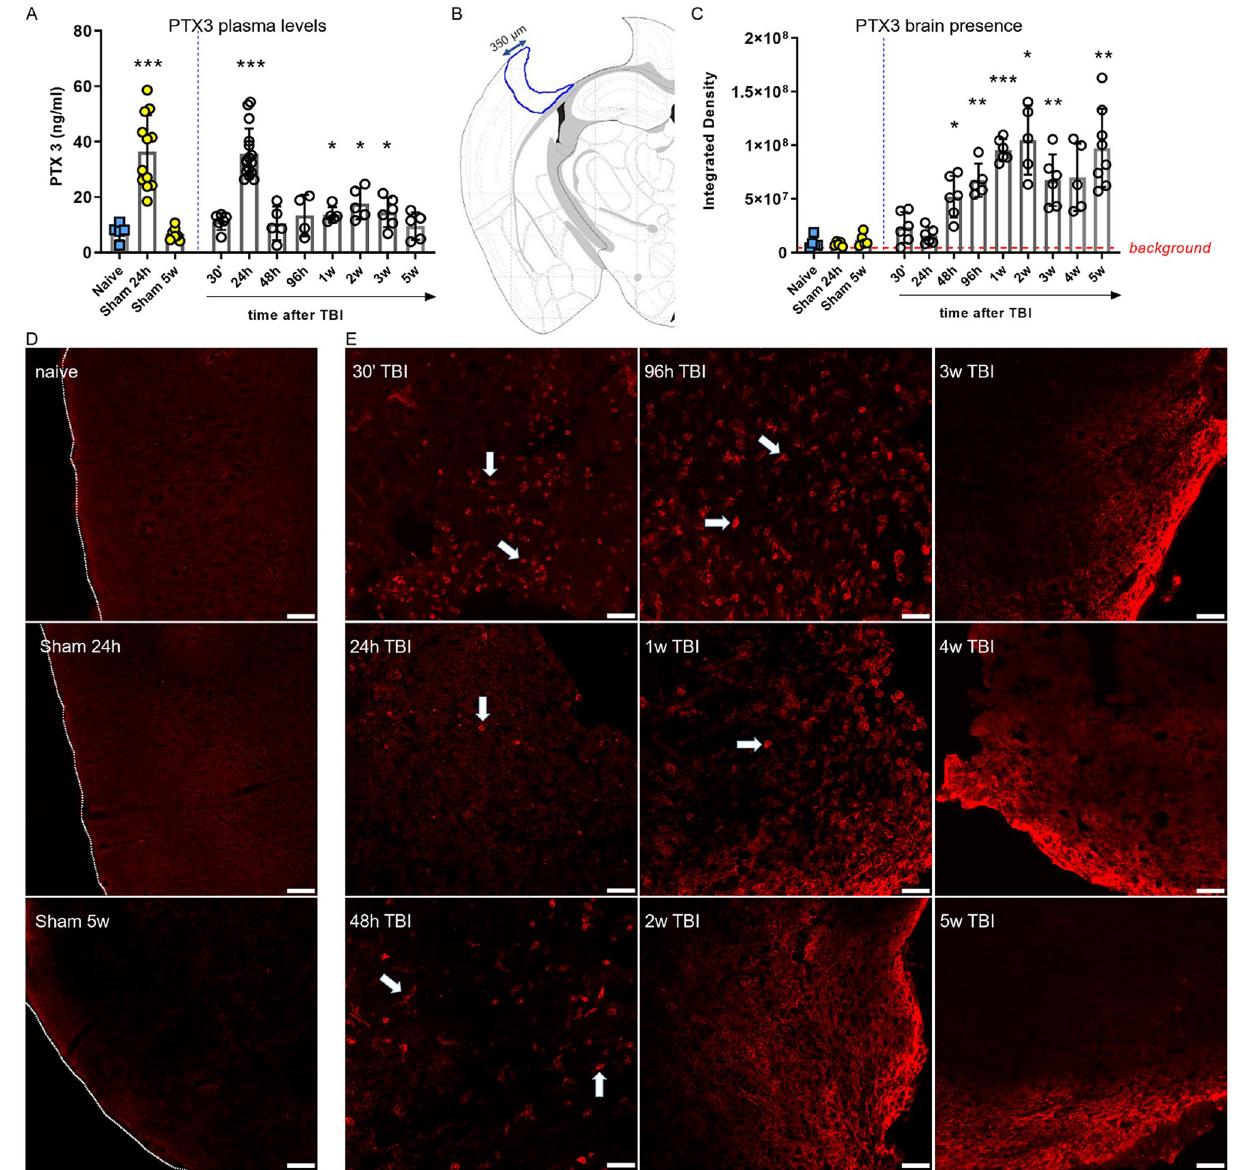
Figure 3. PTX3 protein presence in plasma and in cortex up to 5 weeks after TBI. ( A ) At 24 h plasmatic PTX3 levels increased in both sham and TBI mice. PTX3 levels were significantly higher than naive from week 1 to week 3. Data is presented as mean ± SEM, n = 4 (TBI 96 h), n = 5 (naive, TBI: 48 h, 1w, 2w, 5w), n = 6 (TBI 30 ′ , 3w), n = 16 (sham 24 h), n = 7 (sham 5w), n = 16 (TBI 24 h). Unequal variances per Bartlett’s test, t-test with Welch correction, * p < 0.05, *** p < 0.001, vs naive. ( B ) PTX3 presence in cortex was evaluated by immunofluorescence and quantified in a ROI placed in the il-cortex within the first 350 μm from the edge of the contusion ( B ). ( C ) PTX3 increased starting from 48 h and reached its maximum at 2 weeks after TBI. Data is presented as mean ± SEM, n = 5–6. Unequal variances per Bartlett’s test, one-way ANOVA with Welch correction, * p < 0.05, ** p < 0.01, *** p < 0.001, vs naive. ( D ) Representative confocal microscopy images showing that PTX3 was not present in naïve or sham mice (sacrificed at 24 h and 5w). Tracings indicate the cortex edge, scale bars = 50 µm. ( E ) Representative confocal microscopy images showing PTX3 (red) presence next to cell- like shape (arrows) up to 1 week after injury, while it was located mainly extracellularly at longer time points (from 2 to 5w after TBI). Scale bars = 50